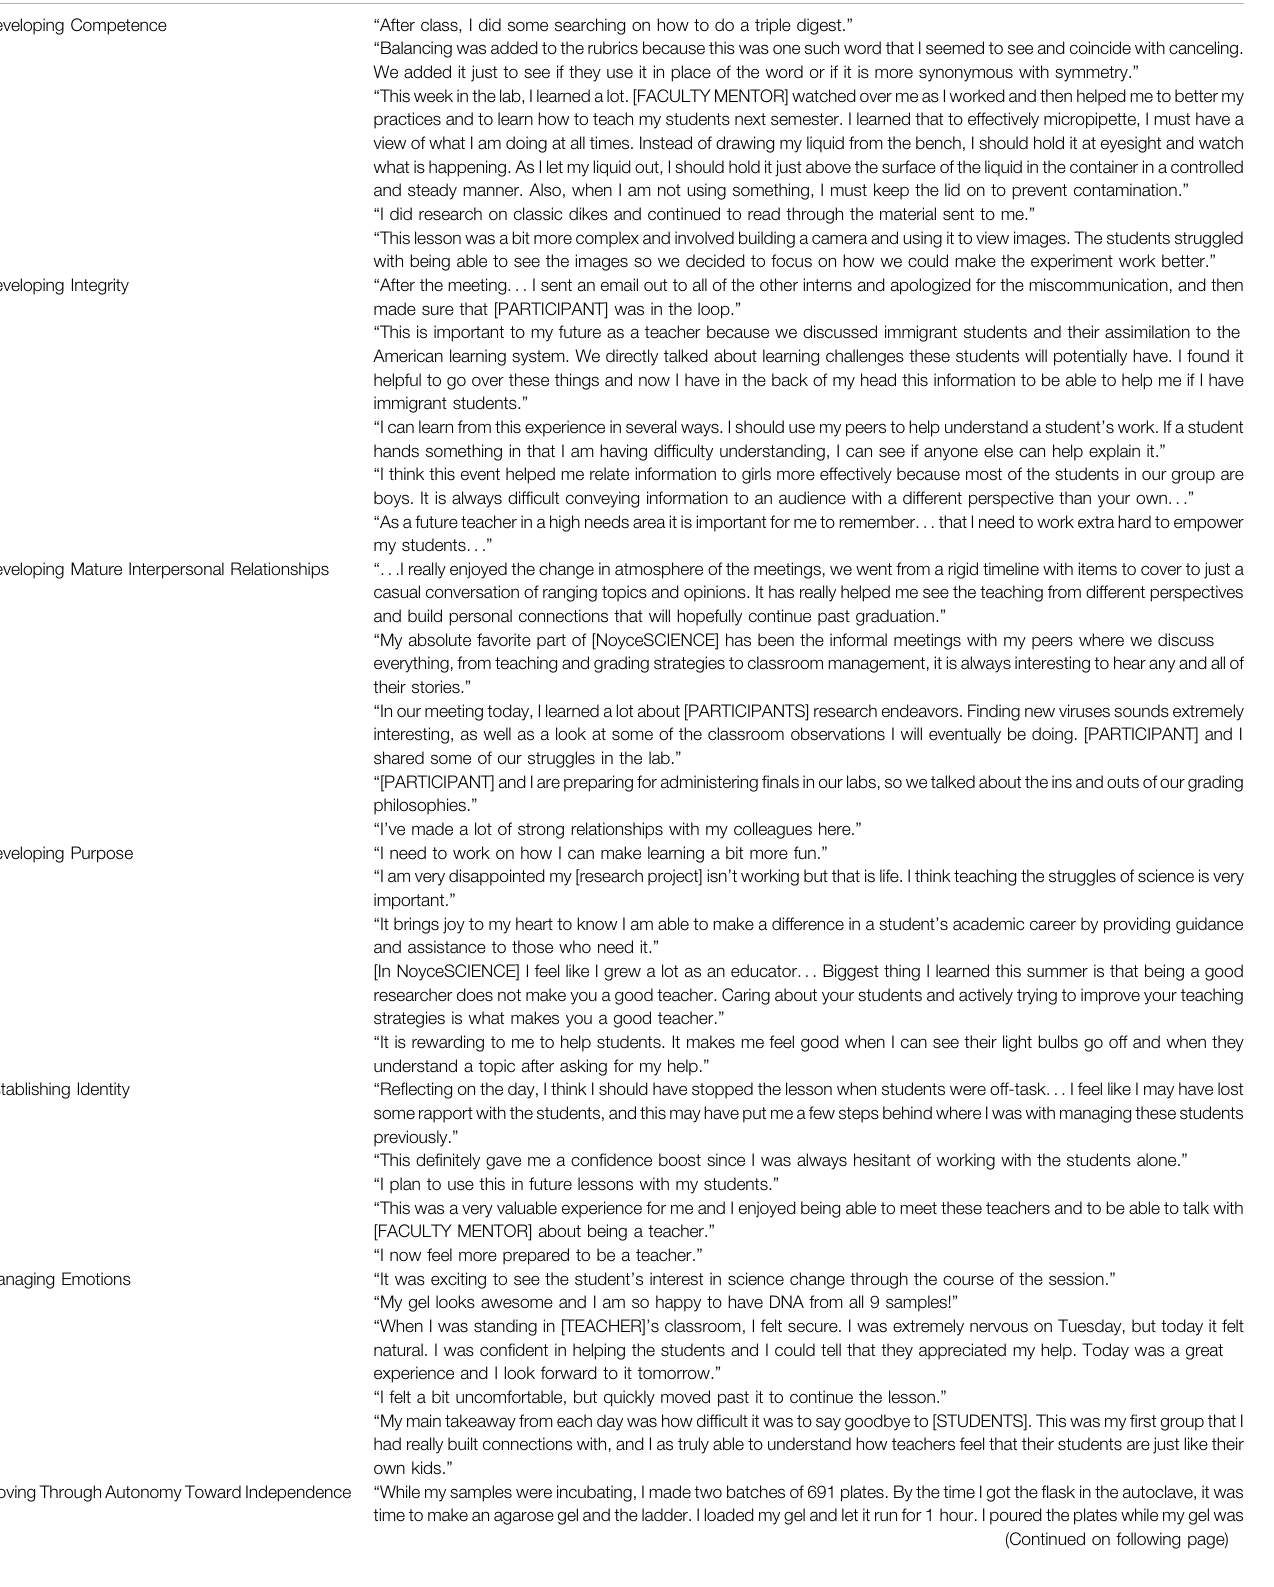
TABLE 2 | Quotes from students that represent each of Chickering ’ s Vectors. Chickering ’ s